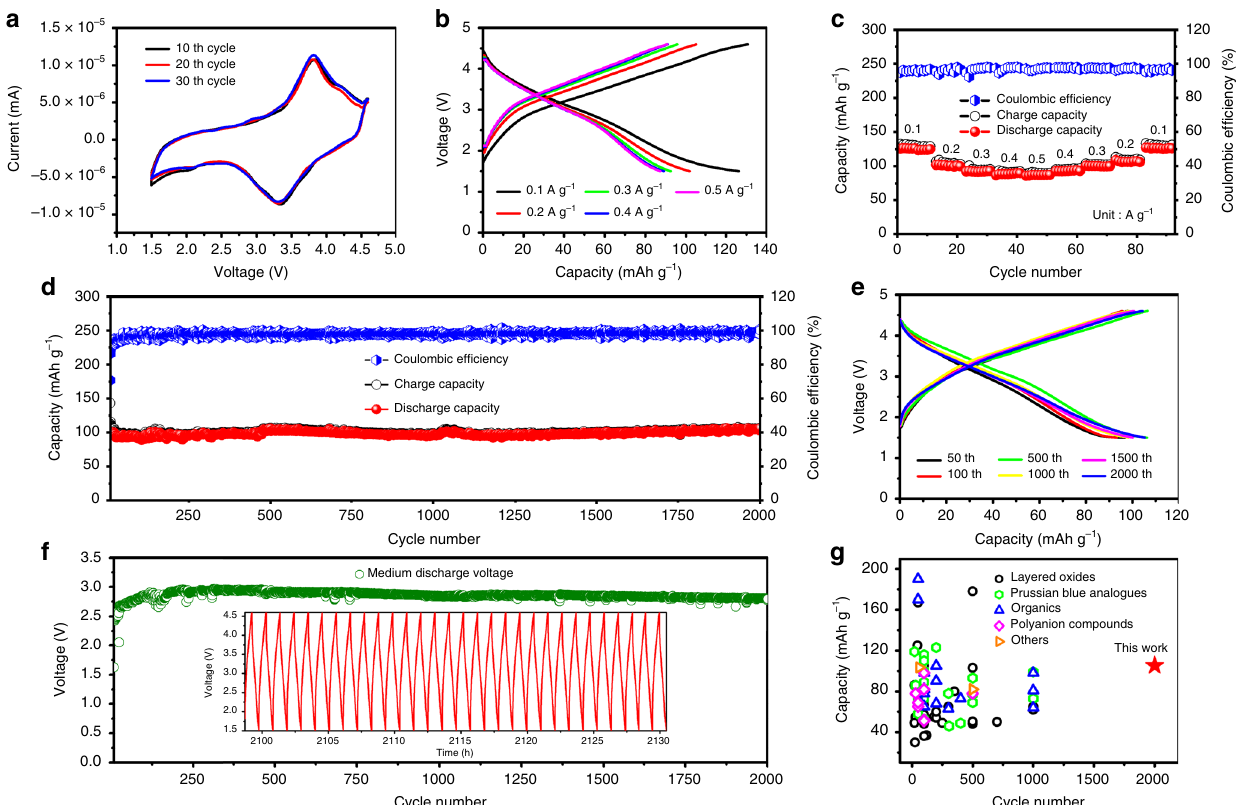
Fig. 2 Electrochemical measurements of KFeC 2 O 4 F in K half-cells. a CV curves in different cycles at a scan rate of 0.1 mV s − 1 . b Galvanostatic charge – discharge curves at different current densities of 0.1 – 0.5 A g − 1 . c Rate performance under different current densities. d Cycling performance at 0.2 A g − 1 for 2000 cycles, and e the corresponding charge-discharge curves of diverse cycles, and f medium discharge voltages. Inset of f is the charge – discharge curves for the fi nal 30 cycles. g The comparison of cycling stability between our work and recently reported cathode materials (detailed in Supplementary Table 2) for potassium-ion